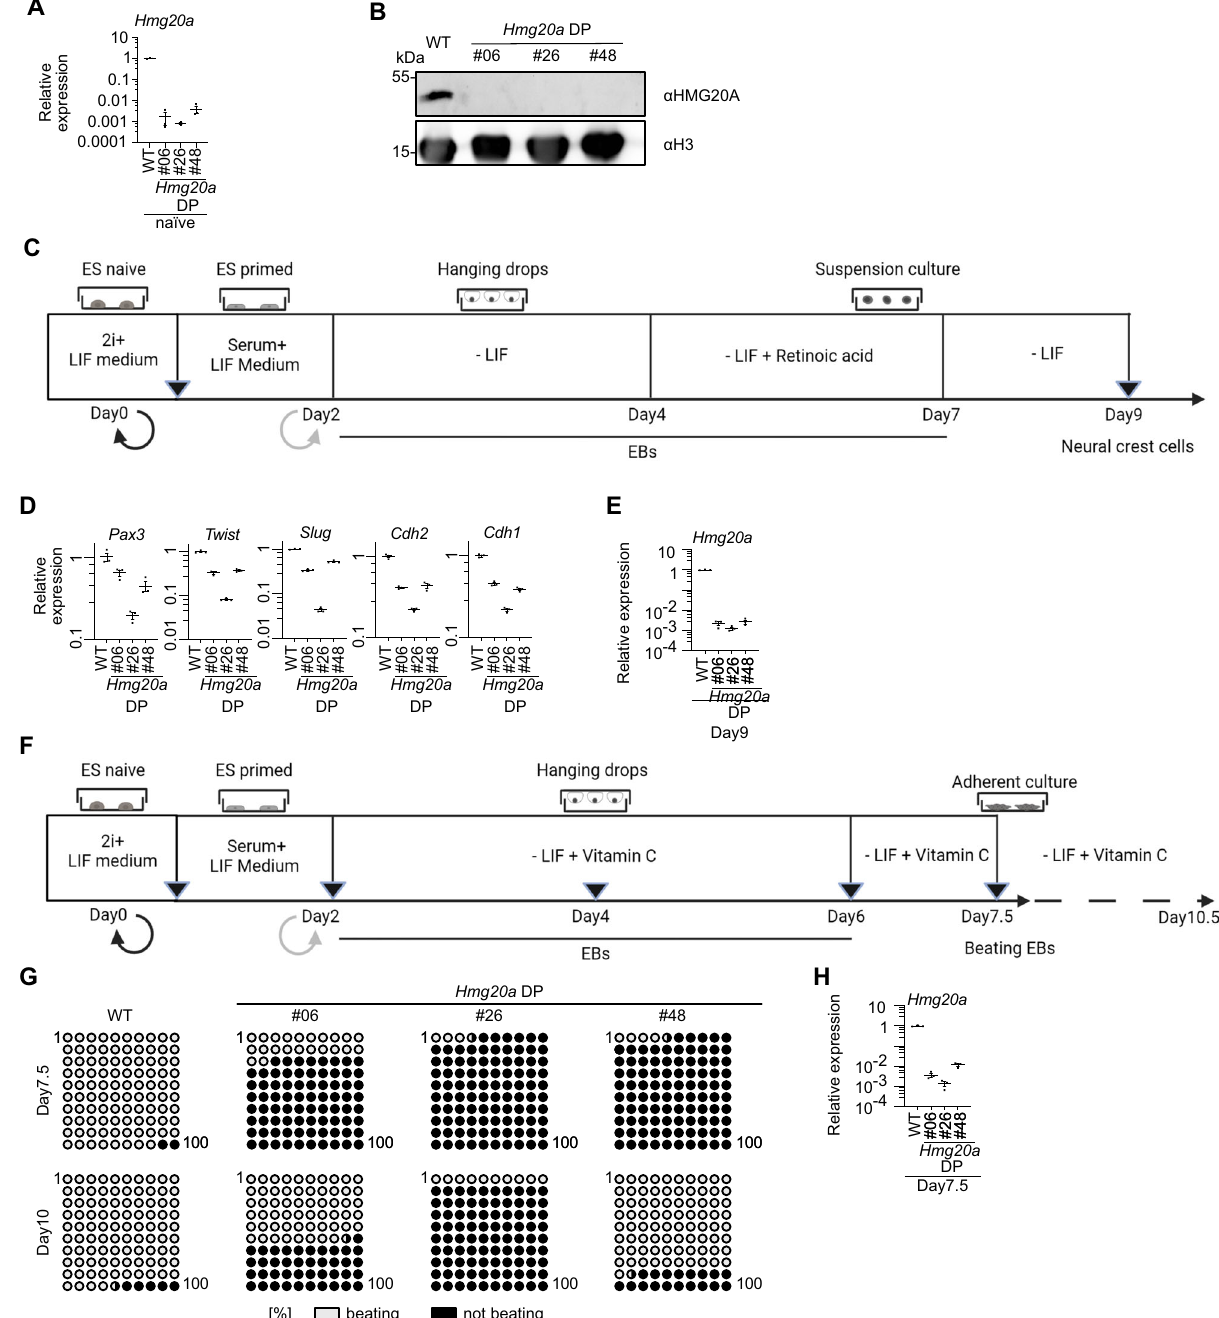
Fig.5|HMG20Aisessentialforcardiomyocyteandneuralcrestdifferentiation inmESCs.A Validationofthree Hmg20a DPclonesbyRT-qPCR.Shownis Hmg20a expression normalized to Hprt . Data is presented as mean±SEM of three tech- nical replicates. B Immunoblot analyses of endogenous HMG20A protein of extracts from WT and three Hmg20a DP mESC clones. H3 served as loading control (shown is one representative blot of two consistent replicates). C mESC neural crest cell (NCC) differentiation scheme. Created with BioRender.com. D RT-qPCR of neural crest and EMT marker genes in WT and three individual Hmg20a DP clones at Day9 of neural crest differentiation protocol normalized to Hprt, 18S RNA and Gapdh expression. Data is presented as mean±SEM of three technical replicates. E RT-qPCR of Hmg20a mRNA in WT and three individual Hmg20a DP clones at Day9 of neural crest differentiation protocol. Expression